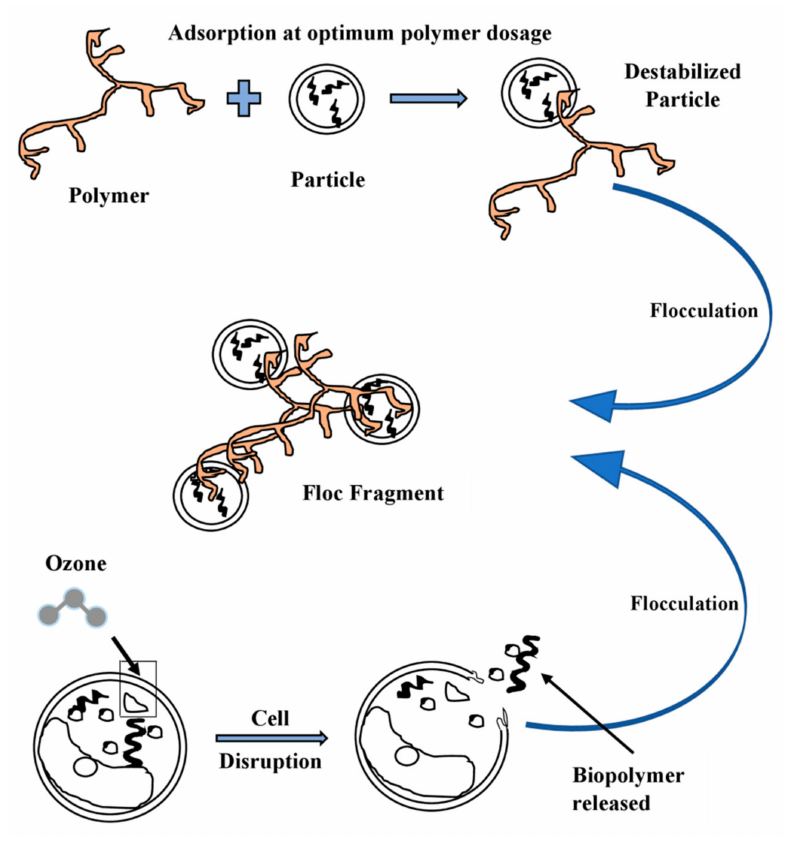
Figure 4. Schematic representation of microalgal cell disruption through